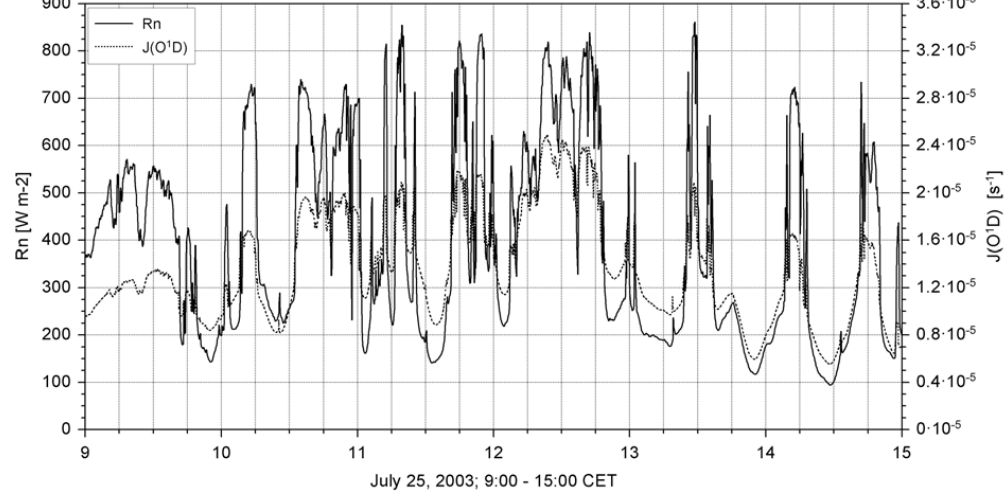
Fig. 1. Net radiation Rn (Wm − 2 ) and J( O 1 D ) – photolysis frequency (s − 1 ) for 25 July 2003, 09:00–15:00 CET above canopy.